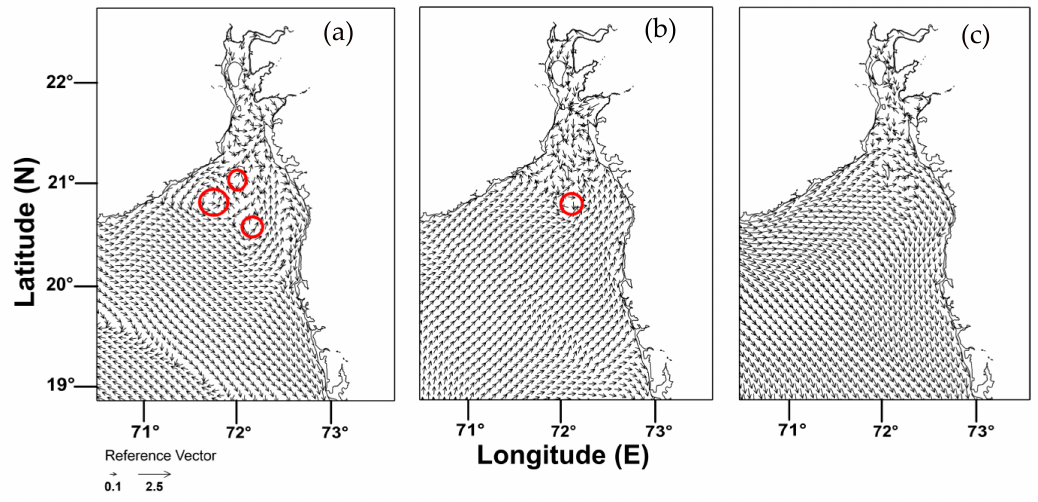
Figure 13. Residual circulation simulated during ( a ) SW-monsoon, ( b ) NE-monsoon, and ( c ) pre-monsoon, where the red line denotes the residual